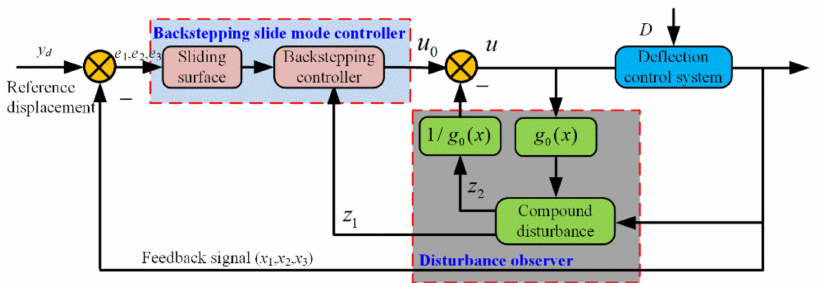
Figure 4. Control diagram of the adaptive backstepping control based on the disturbance observer